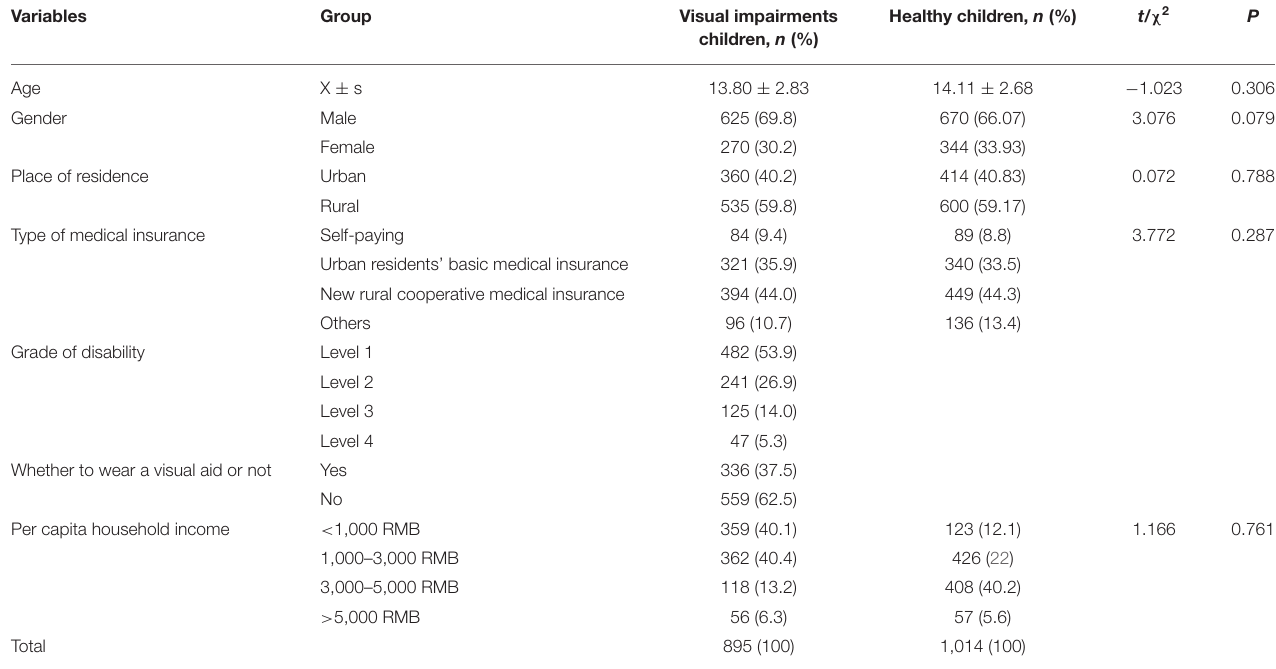
TABLE 1 | Comparison of demographic characteristics between visually impared and healthy children.